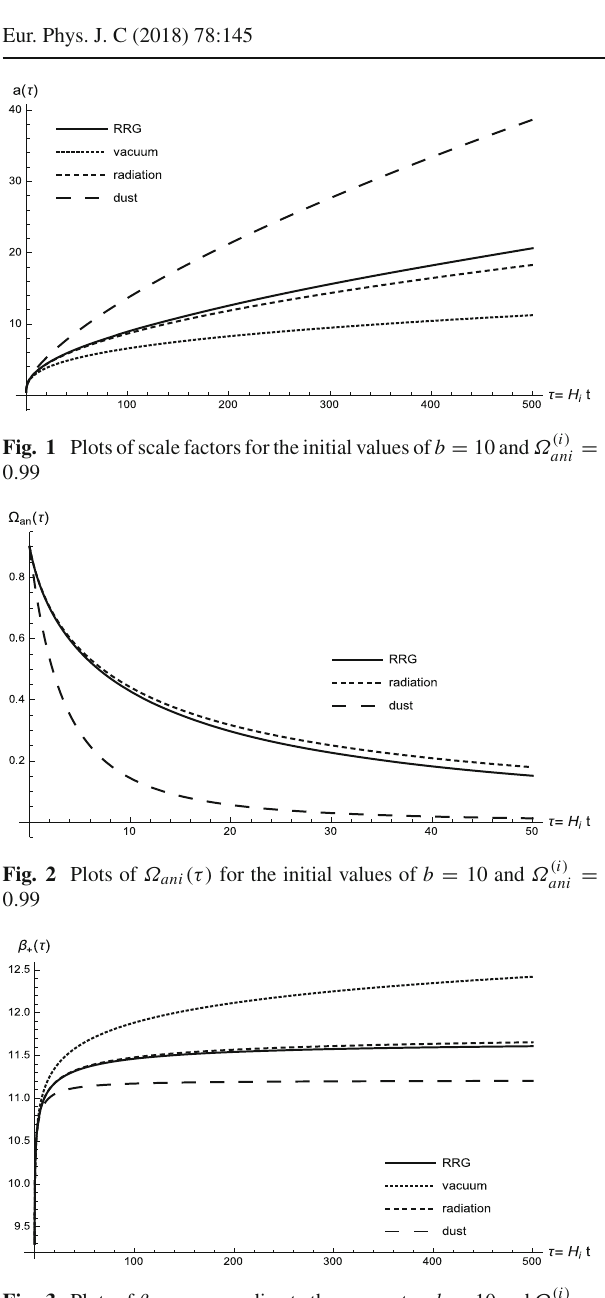
Fig. 3 Plotsof β + correspondingtotheparameters b = 10and Ω ( i ) 0 . 99, while the initial condition β + = 10